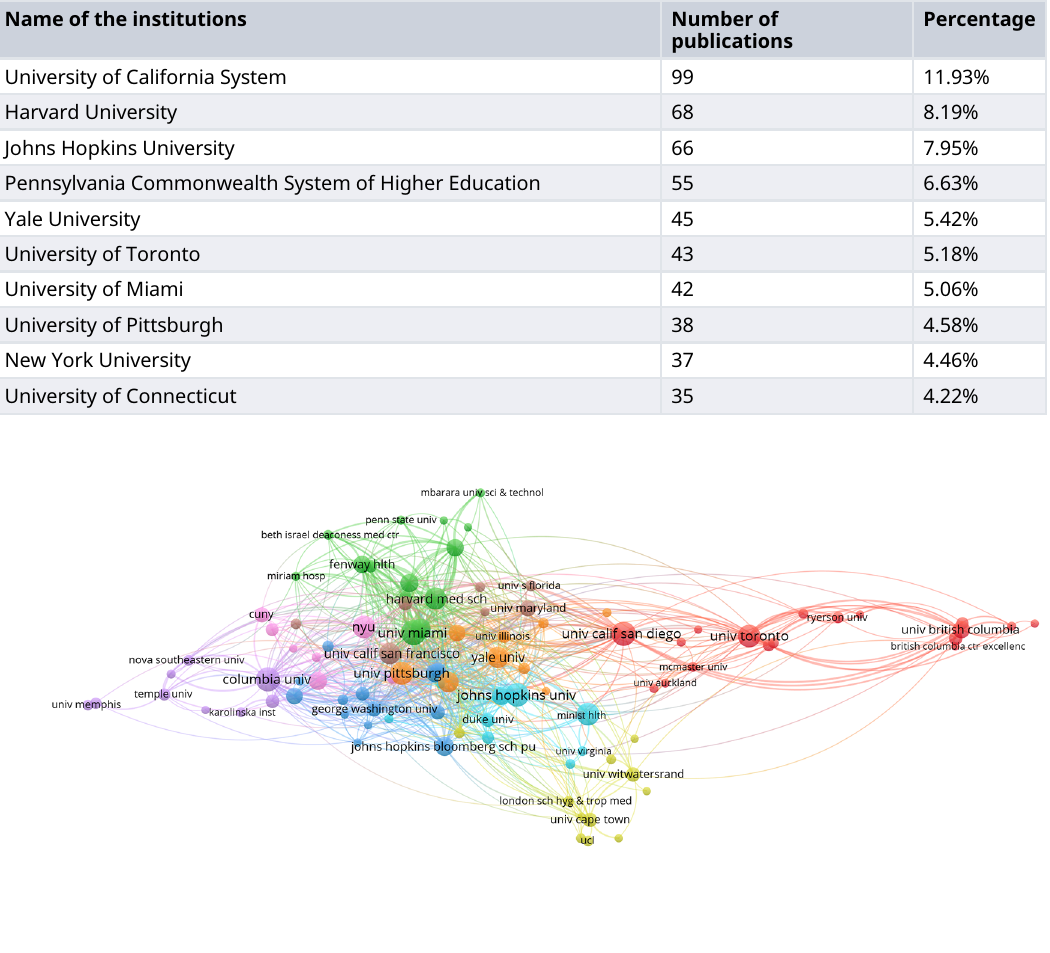
Table 5. Top ten institutions affiliated with syndemics-related publications.